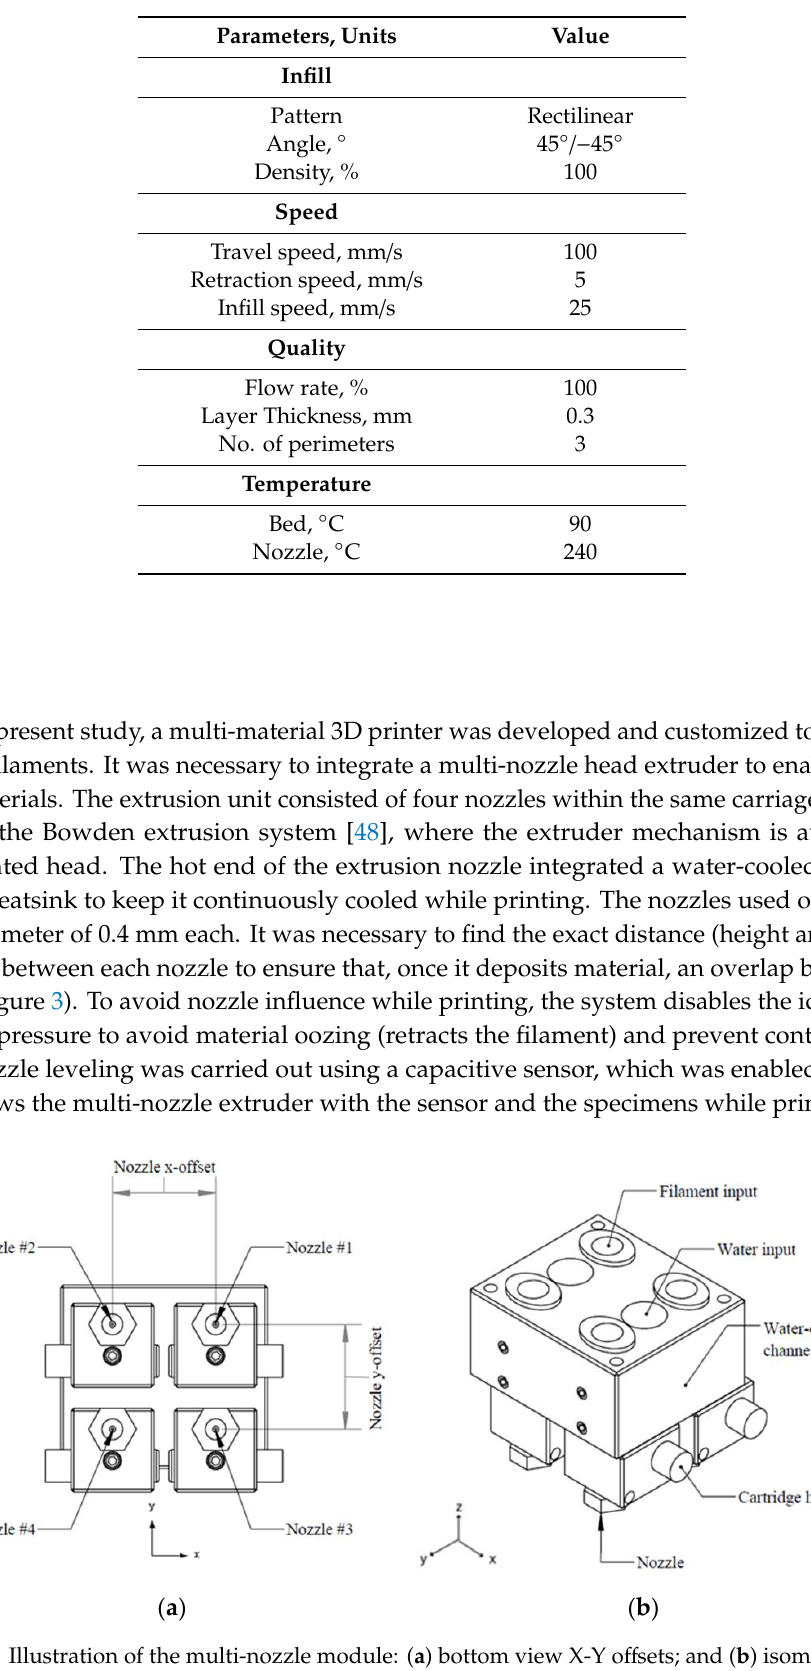
Figure 3. Illustration of the multi-nozzle module: ( a ) bottom view X-Y offsets; and ( b ) isometric view.